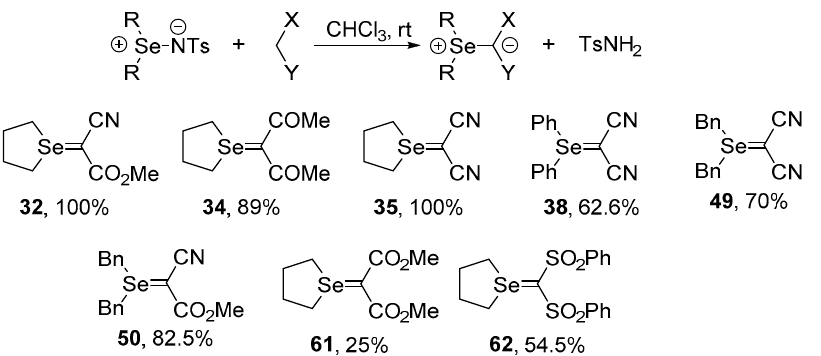
Scheme 18. Preparation of selenonium ylides 18 from selenonium N-p -toluenesulfonimide 64 .